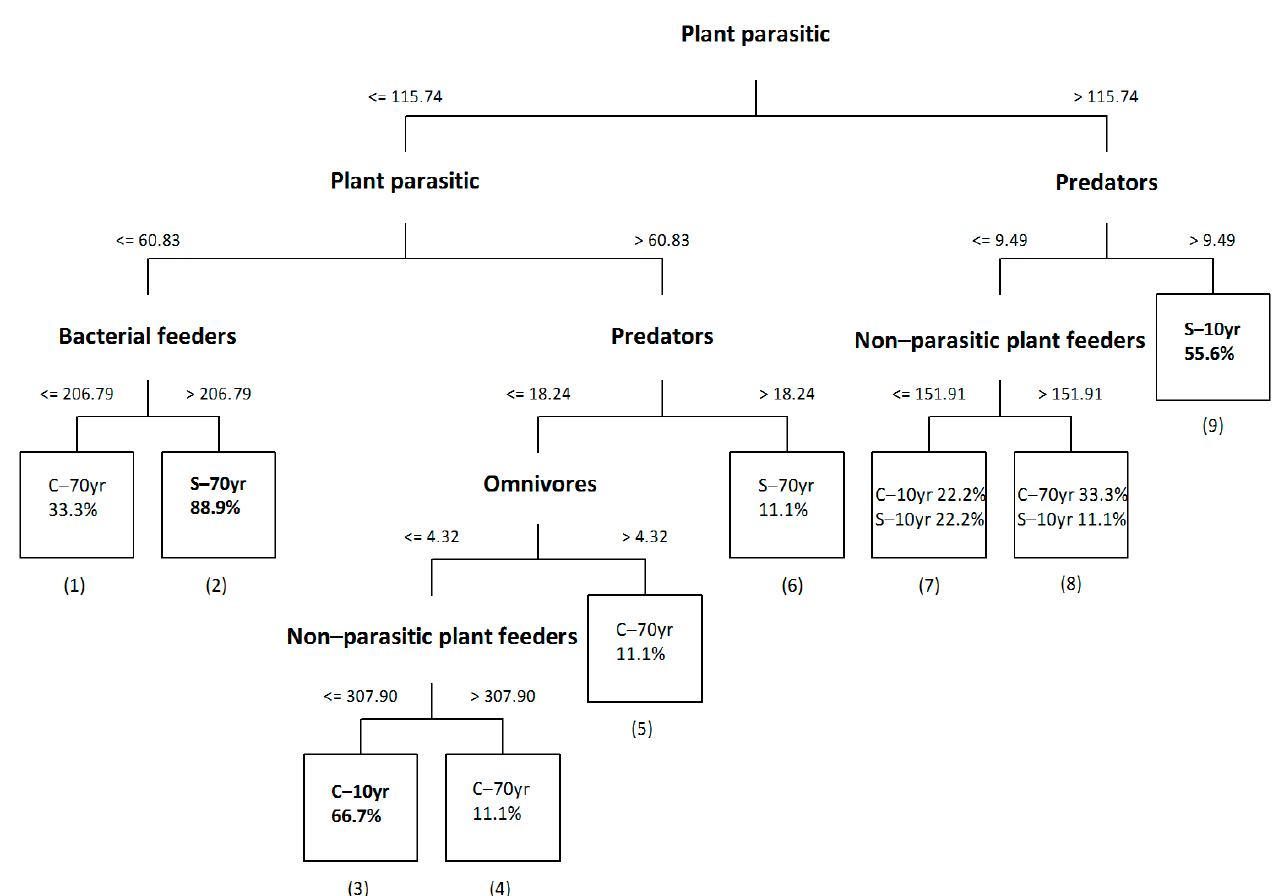
Figure 2. Classification tree based on nematode trophic group abundance (individuals/100 g dry soil) in the rhizospheres of the alien Solanum elaeagnifolium (S) and the native Cichorium intybus (C) in recently (10yr) and historically (70yr) invaded sites. The percentage of correct classification of samples in each node is indicated. Numbers are assigned to all terminal nodes. Pure terminal nodes are indicated in bold.